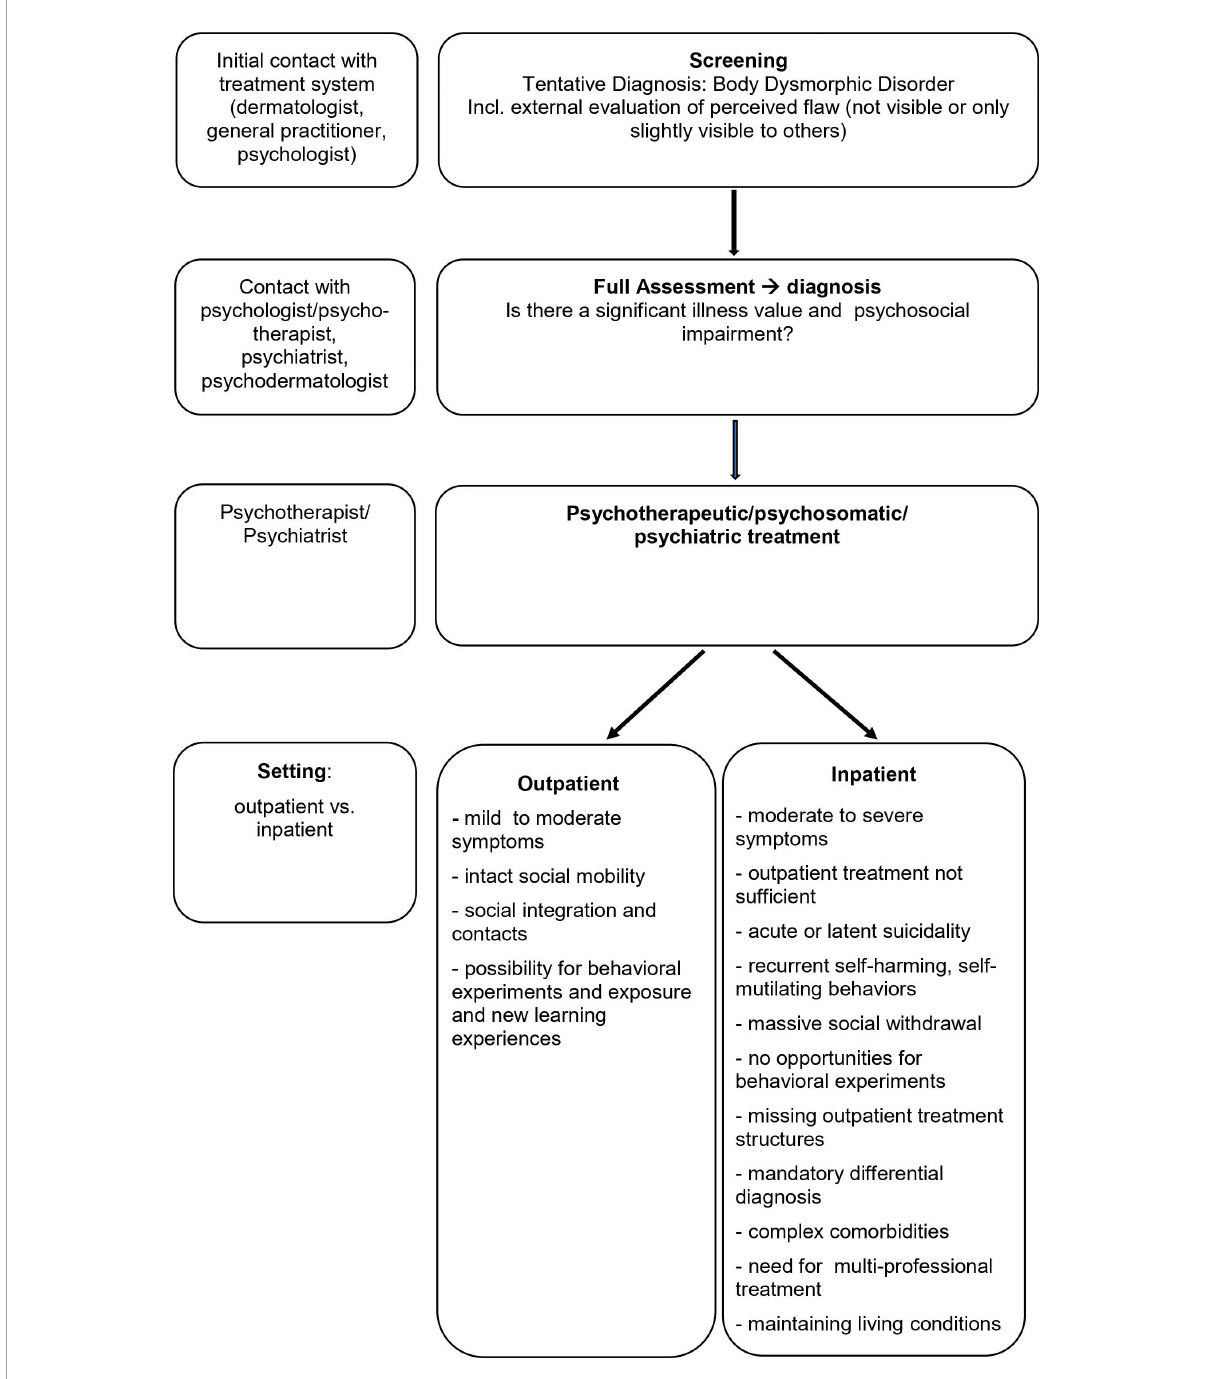
FIGURE1 Criteria for outpatient vs. inpatient